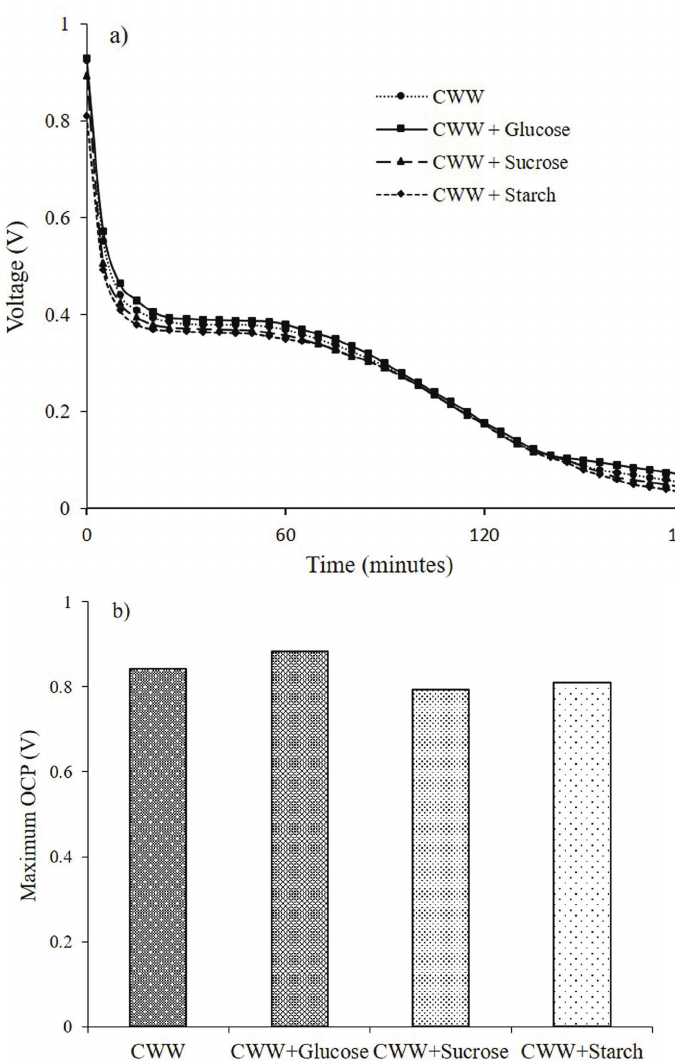
Fig. 6 – Effect of carbon sources on the voltage output (a), and the open-circuit potential (b) of the